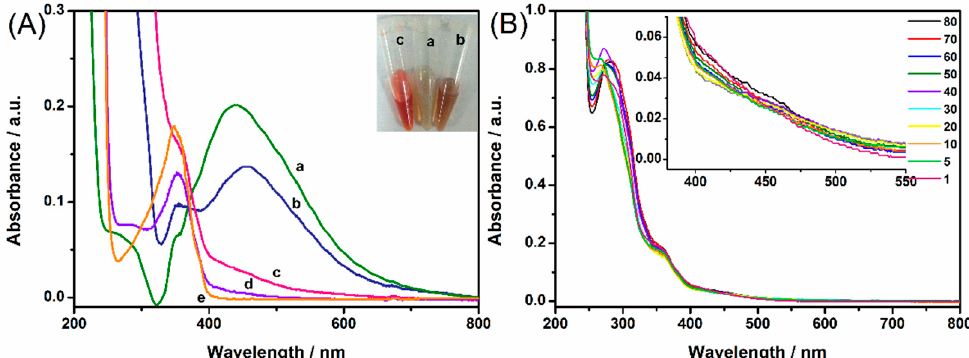
Figure 3. ( A ) UV–vis absorption spectra of Ag NPs (a), Ag NPs-azo mixture at a ratio of 10:1 (b), azo compound derived from 1 mg/mL benzocaine (c), blank sample (d) and diazonium ions from PATP (e). The inset is the visible color change of benzocaine-derived azo product. ( B ) Derivatization time-dependent UV–vis spectra of benzocaine-derived azo solution within 80 min. The concentration of benzocaine was 1 mg/mL and the solutions were diluted at the same multiple.